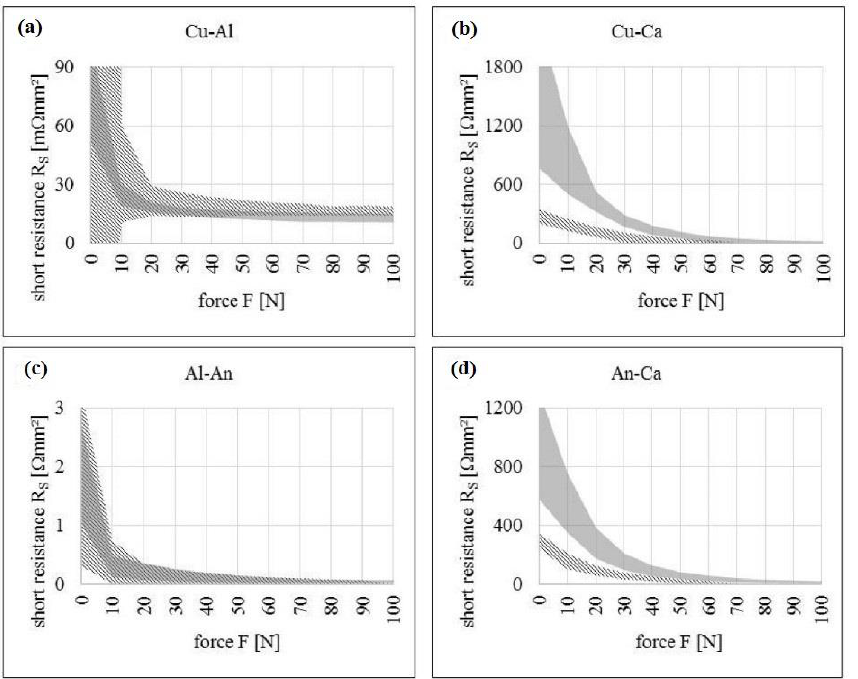
Figure 9. Plots of areal resistance ( y -axis) vs. force ( x -axis); ( a ) Cu–Ca contact scenario, ( b ) An–Ca contact scenario, ( c ) Cu–Al contact scenario, ( d ) Al–An contact scenario. Reprinted from ref. [135].